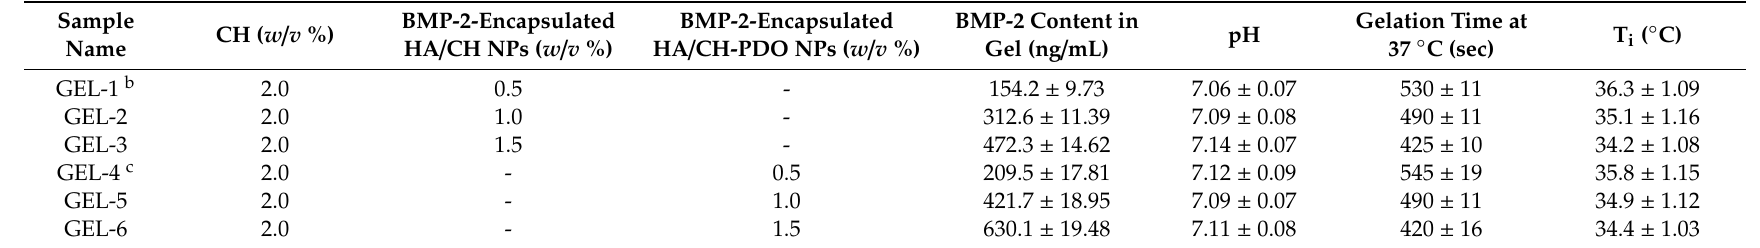
Table 4. Parameters for hydrogels containing BMP-2 a